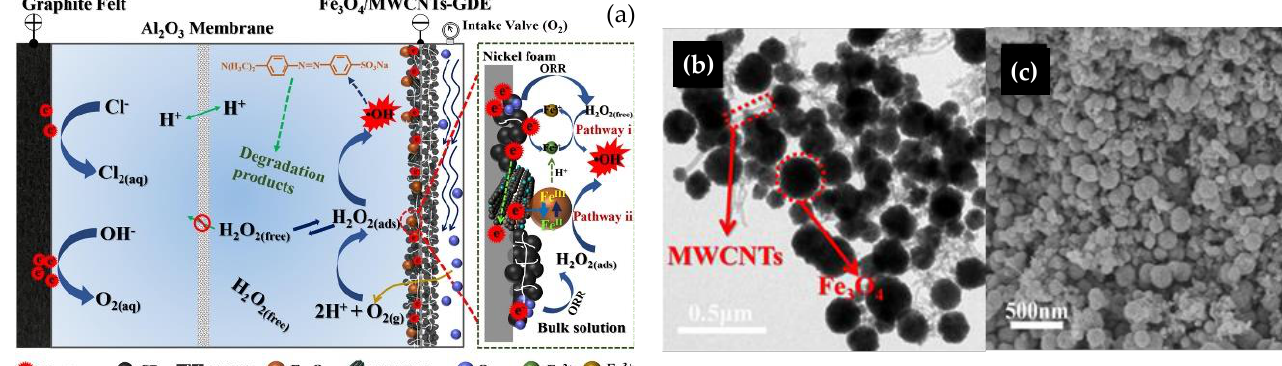
Figure 14. ( a ) Possible heterogeneous EF catalytic mechanisms using Fe 3 O 4 /MWCNTs/CB GDE dual − composite. ( b ) TEM and ( c ) SEM images of Fe 3 O 4 /MWCNTs/CB composite [297].